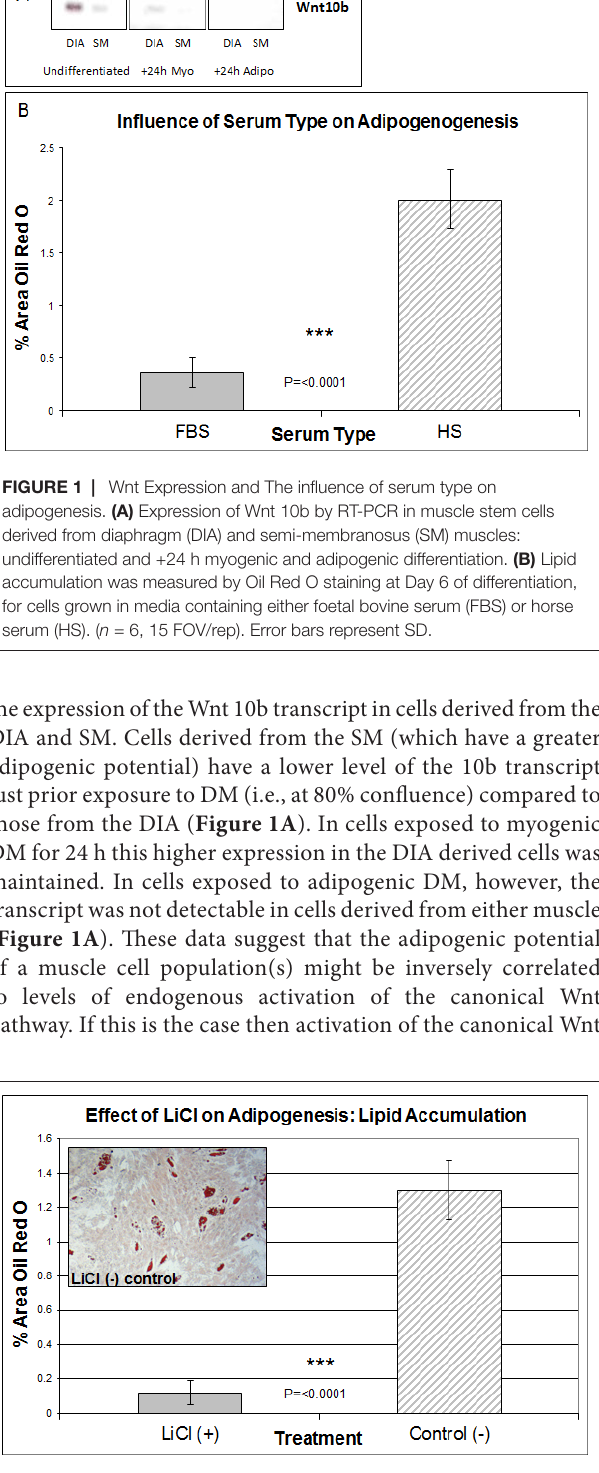
Figure 2 | The effect of LiCl on adipogenesis. Lipid accumulation was measured by Oil Red O staining at Day 6 of differentiation, following treatment with LiCl ( n = 6, 15 FOV/rep). Inset image representative of Oil Red O staining for control cells. Error bars represent